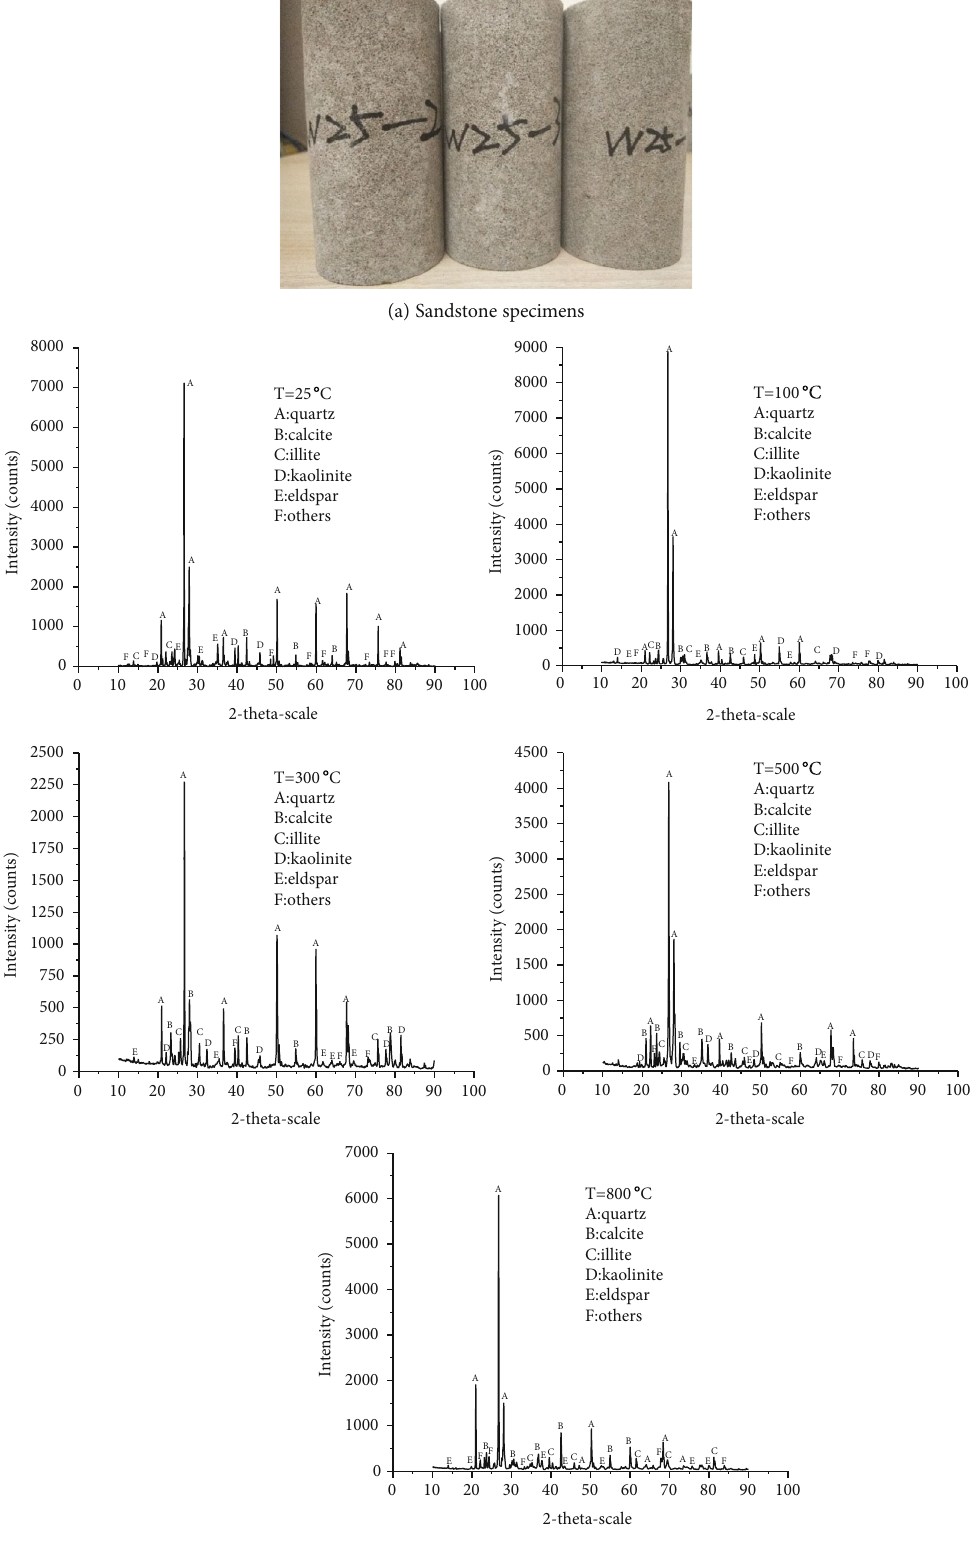
(b) XRD distribution of the sandstone specimens Figure 1: The specimens and corresponding XRD